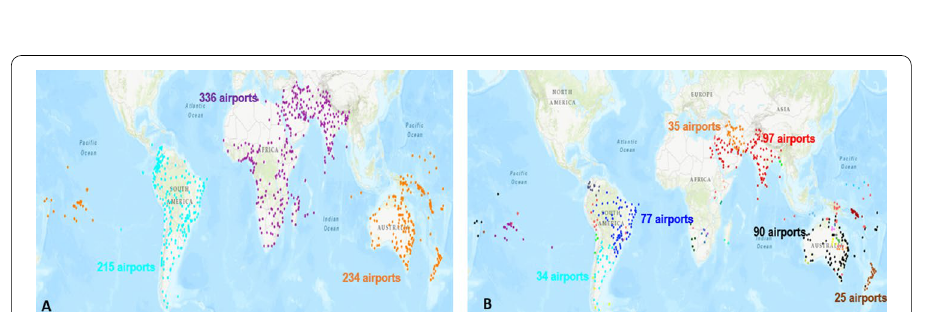
Fig. 4 Large communities uncovered by Louvain split into multiple communities by LPA. a Louvain reveals 3 communities. The indigo points represent the airports located in Africa-Middle East-Southern Asia. The orange points represent the airports located in Oceania. The cyan points represent the airports in South America. b LPA uncovers 57 communities in the same geographical areas. There are 16 communities in Africa-Middle East-Southern Asia, 28 in Oceania, and 13 in South